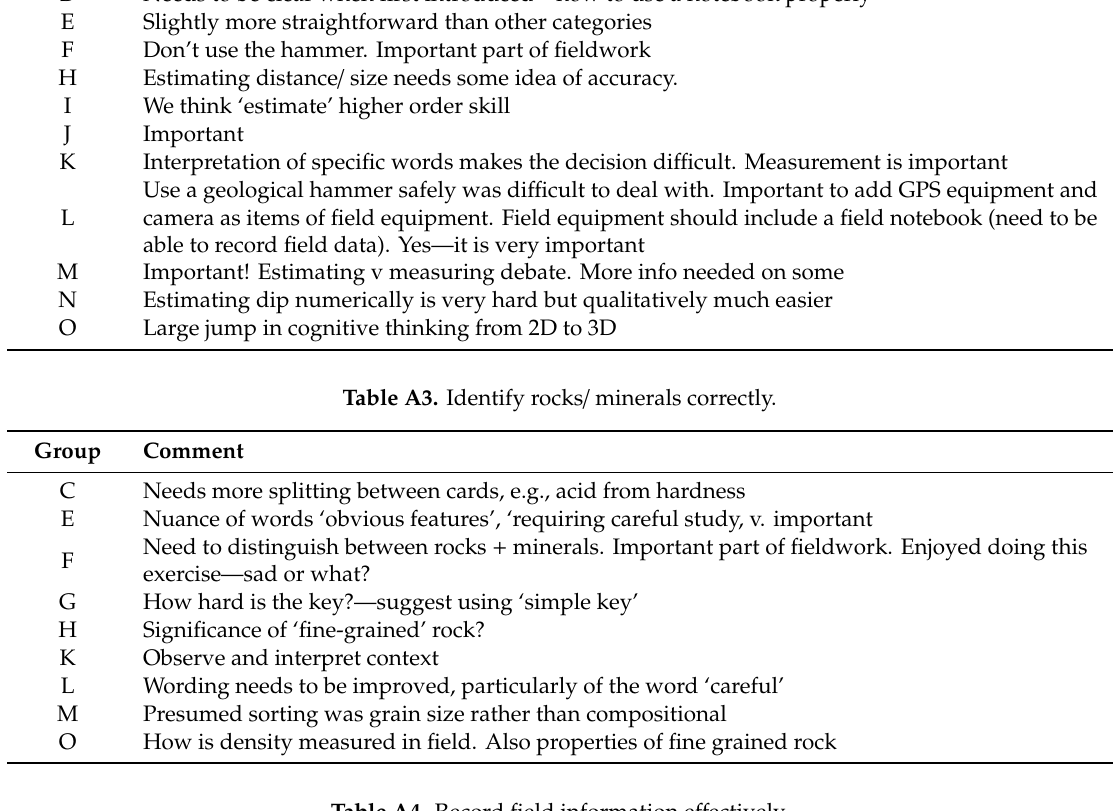
Table A4. Record field information e ff ectively.